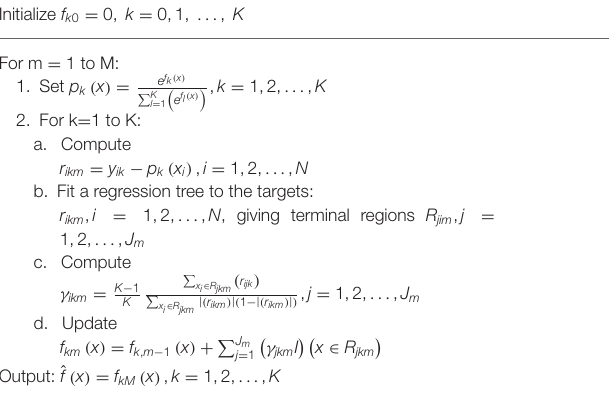
TABLE 1 | GBM procedure in H 2 O